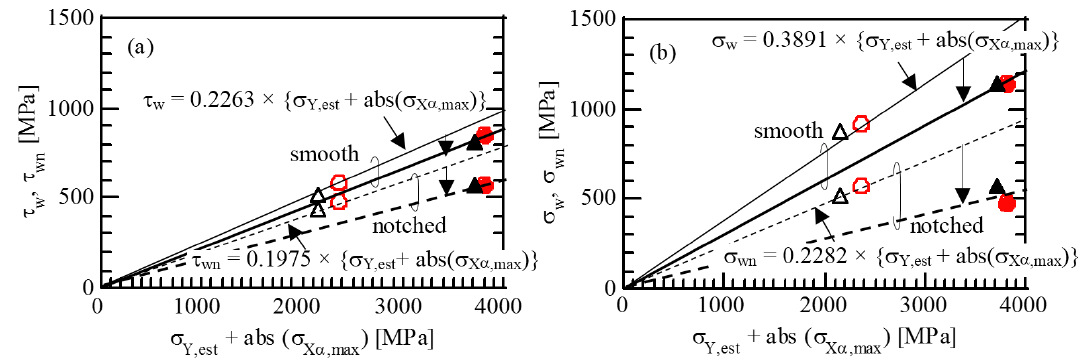
Figure 11. Variations in ( a ) torsional ( τ w , τ wn ) and ( b ) rotational bending fatigue limits ( σ w , σ wn ) for smooth and notched specimens as a function of the sum of estimated yield stress and absolute value of maximum compressive residual stress { σ Y,est + abs( σ Xα,max )} in TM (● ○ ) and SNCM420 ( ▲ △ ) steels subjected to vacuum carburization and subsequent fine particle peening (● ▲ , thick lines ) and heat-treatment and subsequent fine particle peening ( ○ △ , thin lines).